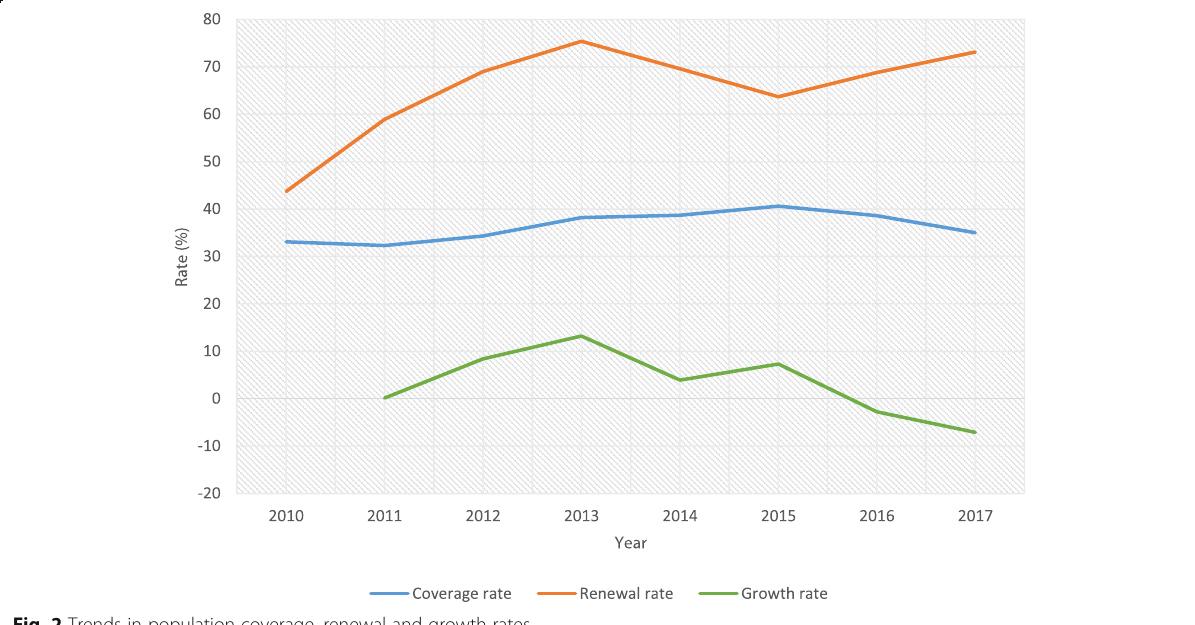
Fig. 2 Trends in population coverage, renewal and growth rates